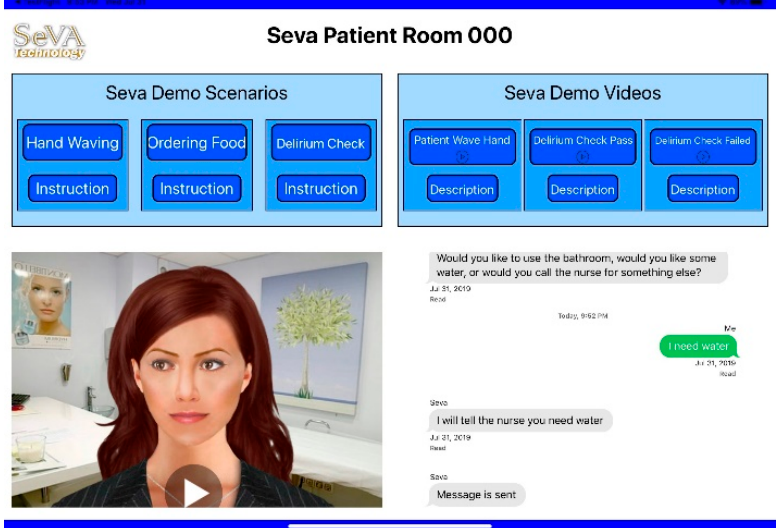
Figure 6. SPR application user interface.